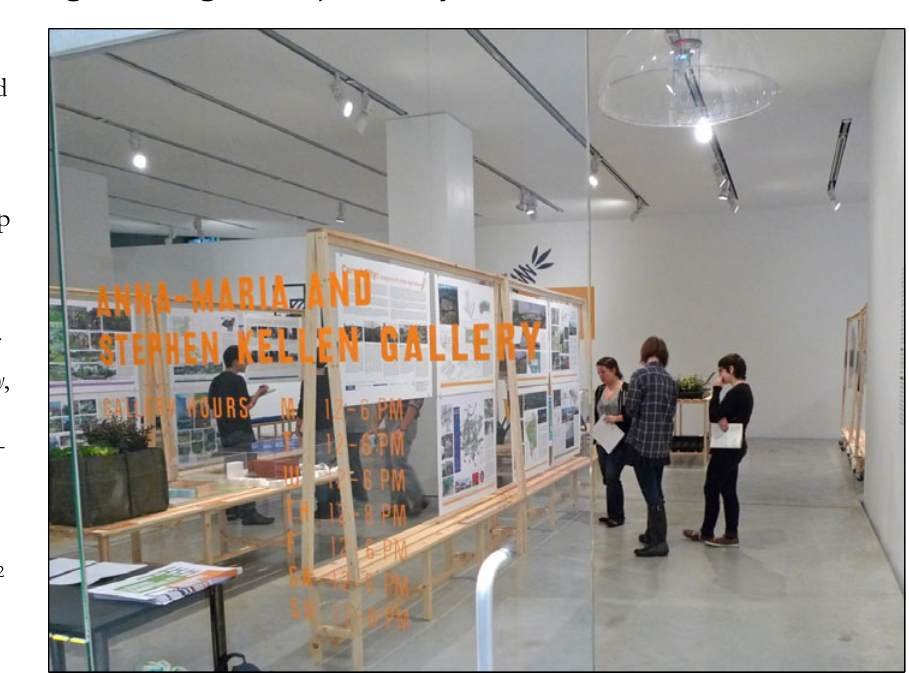
Figure 1. Living Concrete/Carrot City